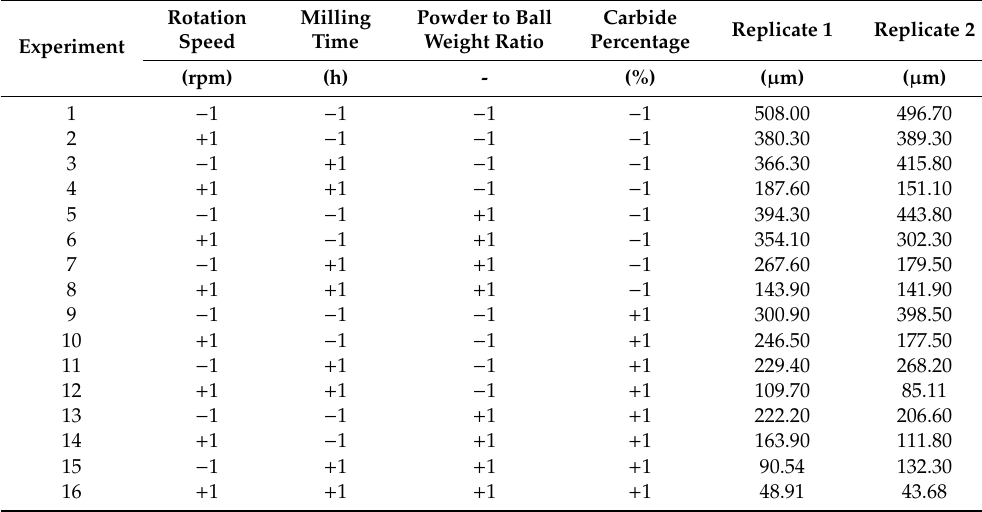
Table 2. Average particle sizes of duplex stainless steel for the investigated milling parameters (experimental matrix in coded variables).